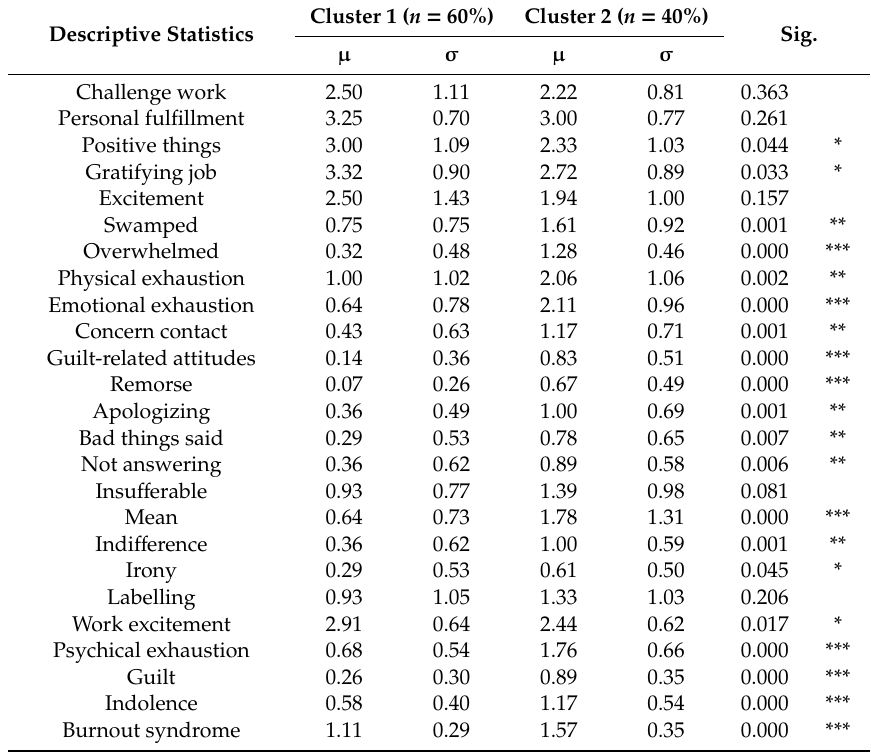
Table 3. Descriptive analysis and significance tests -ANOVA- of the attributes and the dimensions of CESQT for the two clusters